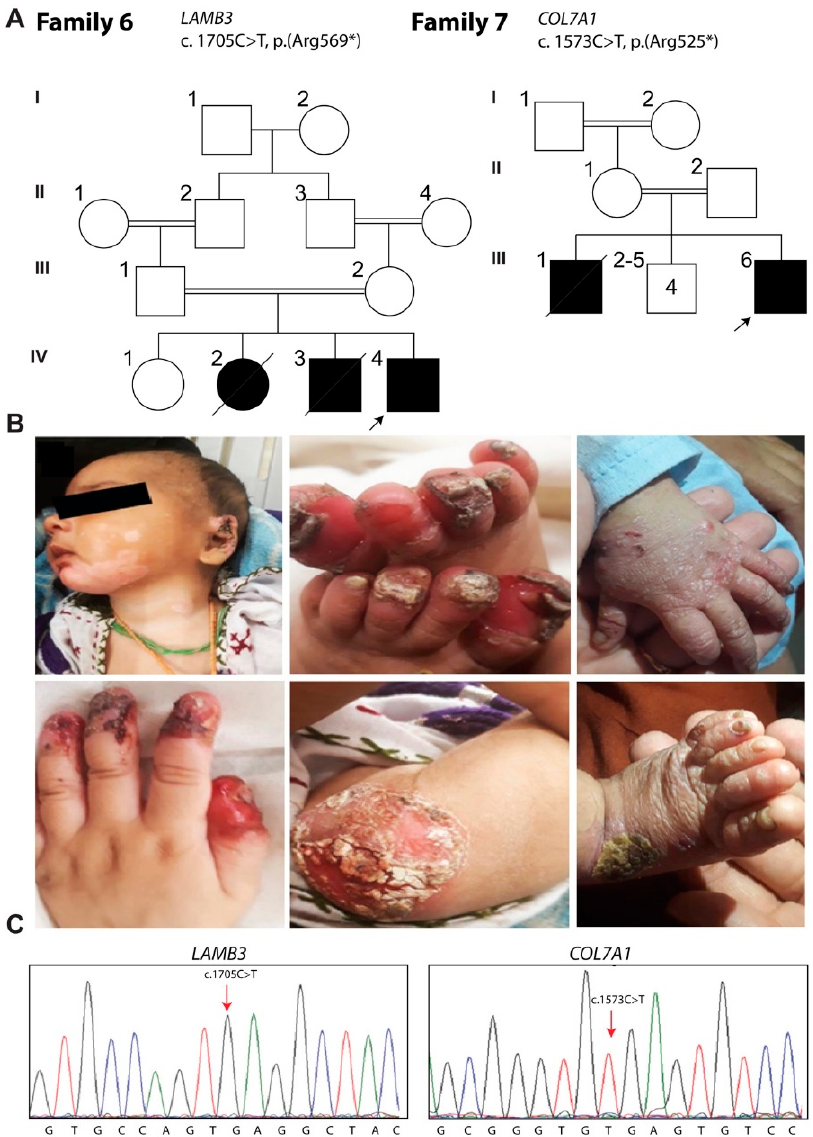
Figure 5. The EB phenotype in family 6 and 7 is associated with pathogenic variants of LAMB3 and COL7A1, respectively. ( A ) Pedigrees of family 6 and 7. ( B ) Hypopigmented patches on front of upper chest, neck and chin with crust plaque on the left ear, erythematous and ulcerated lesions with nail dystrophy, hyperkeratotic annular plaque, demarcated erosions with erythematous base, milia on both hands and onychogryphosis, and a single yellowish crusted lesion along with onychogryphosis and anonychia. ( C ) Chromatogram showing homozygosity of identified variants in the patients: (c.C1705T) in IV:4 and (c.C1573T) in III:6. The asterisk indicates premature termination